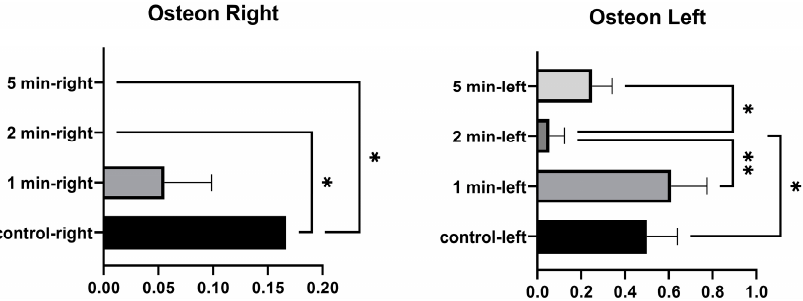
Figure 7. Osteon graphs of the left and right tibia. ( p ≤ 0.05) as *, ( p ≤ 0.01) as **. Table 5. Osteon table of the left and right tibia.